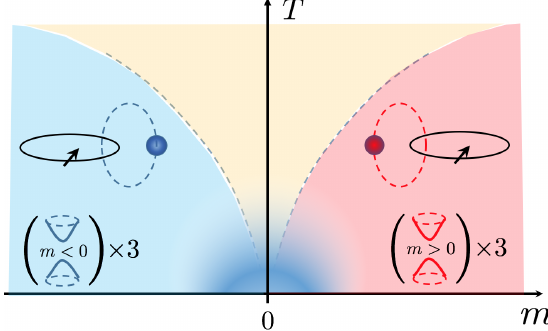
FIG. 8. Deep in the large m < 0 and m > 0 phases (the discussion of small fermion mass is postponed to the next section), in the bulk, the SU ð 2 Þ gauge theory is in a confined phase, where all electric flux lines have line tension. In the infinitely massive spectator limit, the spin- 1 = 2 electric flux loops cannot break. The system has a global 1-form Z 2 symmetry. We can couple the system to a background 2-form Z 2 gauge field. The Z 2 flux of the 2-form gauge field physically corresponds to the SO ð 3 Þ magnetic monopole. It has a nontrivial π mutual braiding phase with the spin- 1 = 2 electric flux loops. The statistical and symmetry properties of the SO ð 3 Þ monopole are different between the m < 0 phase and the m > 0 phase because of the topological band structure of the adjoint